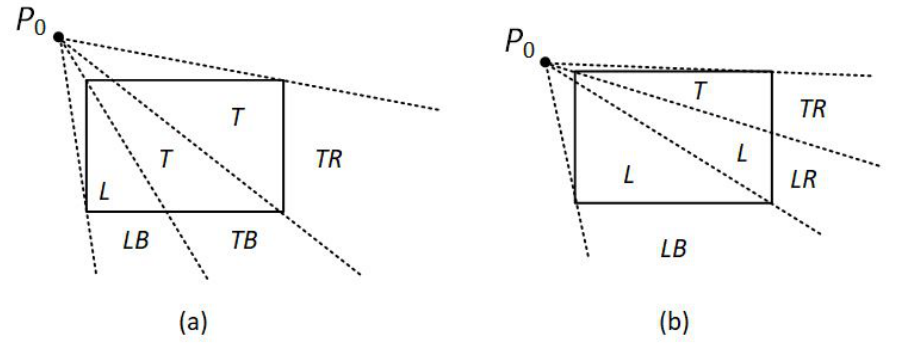
Figure 13. The four clipping regions when P 0 is on the edge region.